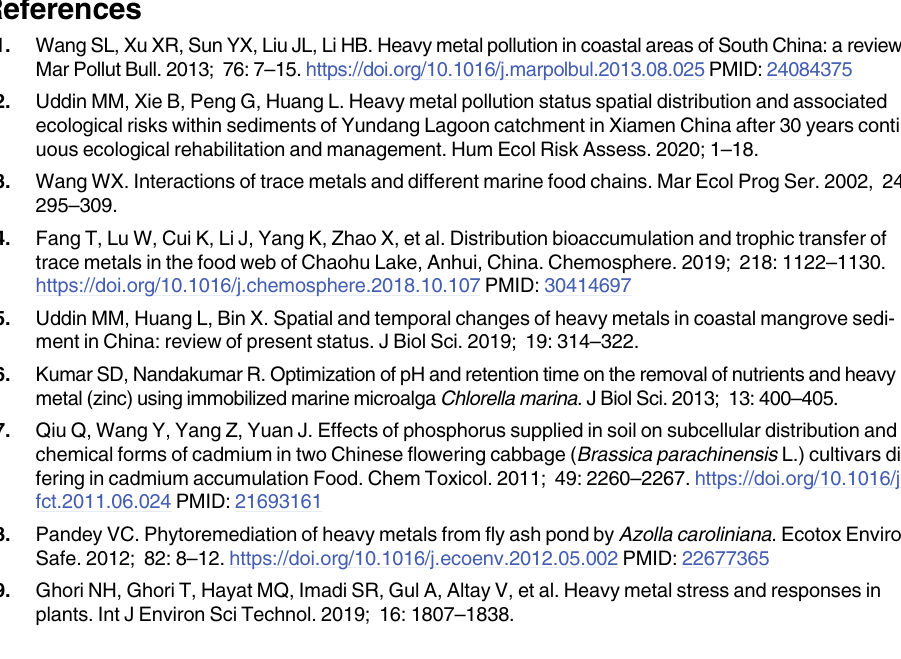
S2 Table. Average chemical forms of Cd fractions (mgKg -1 FW) in leaves, stems and roots of S . portulacastrum under different Cd